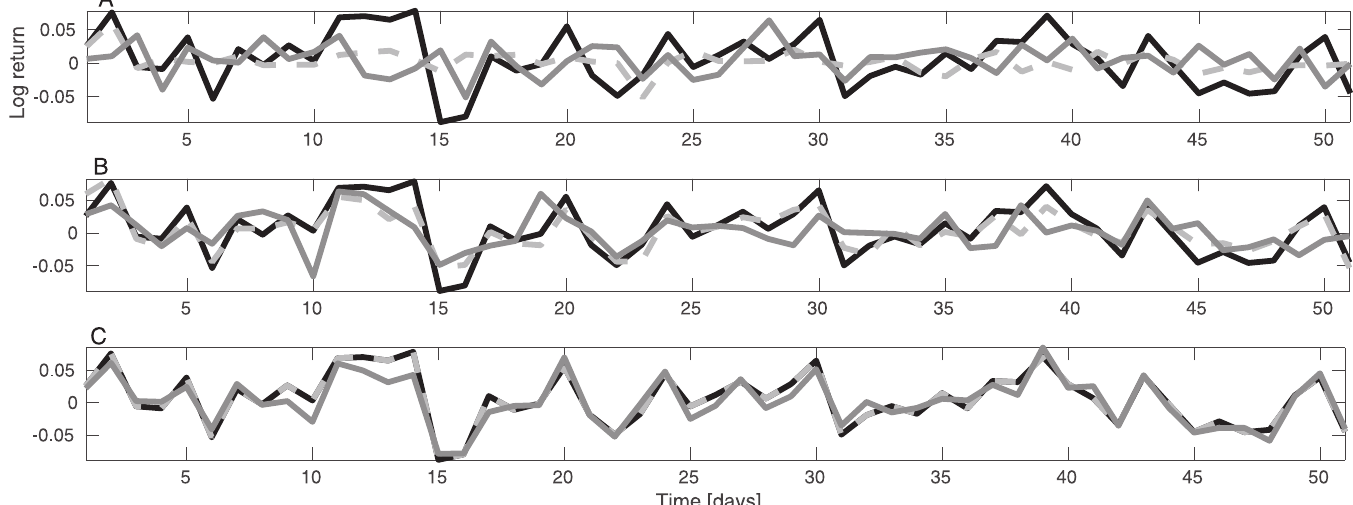
Fig 1. An example reproduction of logarithmic return time-series using the random factor model (dark grey curves) and PCA (dashed light grey curves) compared with the observed equity time-series (solid black curves) using 10 (top panel), 100 (middle panel), and 500 factors. The data is normalized to have zero average return, as describes in the text.